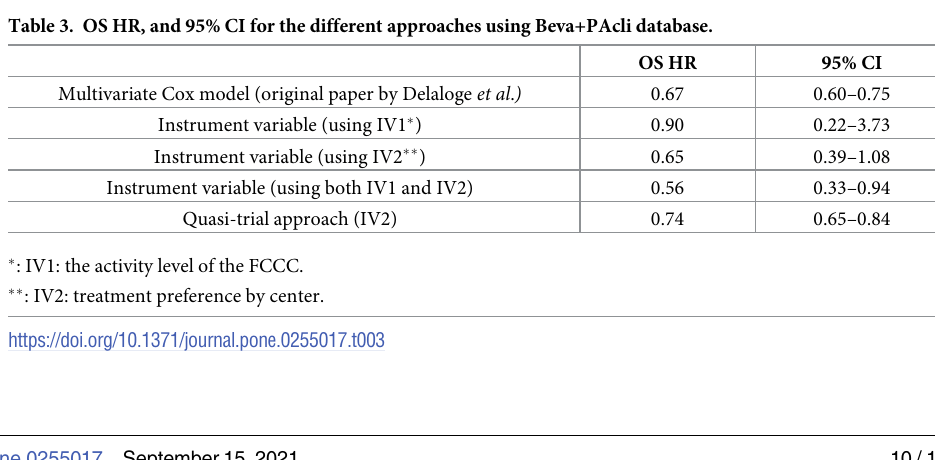
Table 3. OS HR, and 95% CI for the different approaches using Beva+PAcli database. Multivariate Cox model (original paper by Delaloge et al .